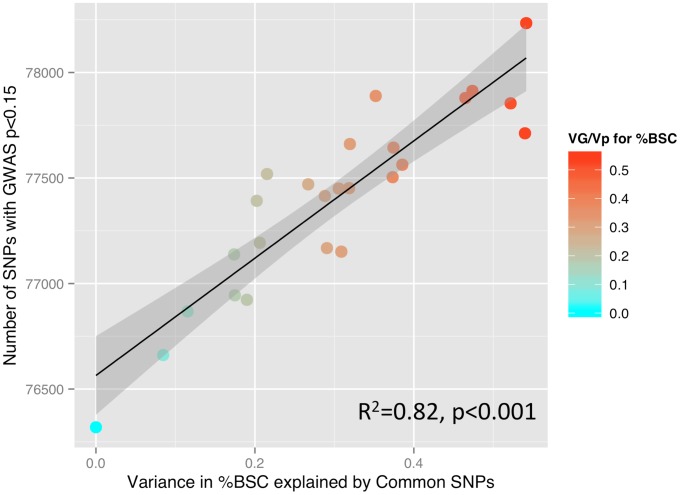
SNP-based estimates of heritability and the number of SNPs detected in a GWAS.Relationship between GREML-based heritability estimates (Genetic Variance/Phenotypic Variance) and the number of single nucleotide polymorphisms (SNPs) showing a significant relationship with percent BOLD signal change (%BSC) at a threshold of p<0.15 (see the Results section for rationale). P values for this analysis were obtained using linear regression.